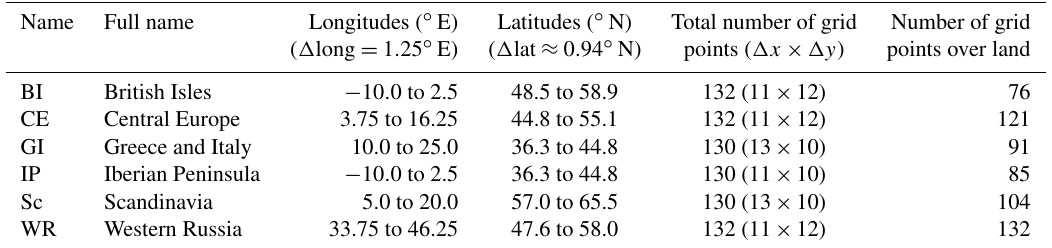
Figure 1. The 90th percentile of daily maximum 2m temperature in August: (a) historic time slice (1991–2000), in degrees Celsius; (b) dif- ference (in K) between future (2091–2100) and historic time slices. Shown is the 90th percentile centered on 15 August, which is derived by taking into account all daily maximum temperatures from 1–31 August (15 August ± 15d) in the respective time slice. Colored boxes show the outline of the different European regions (see Table 1). Table 1. Definition of regions representing different European climates (following Zschenderlein et al., 2019, with adaptions to the CESM-LE data). Latitudes are